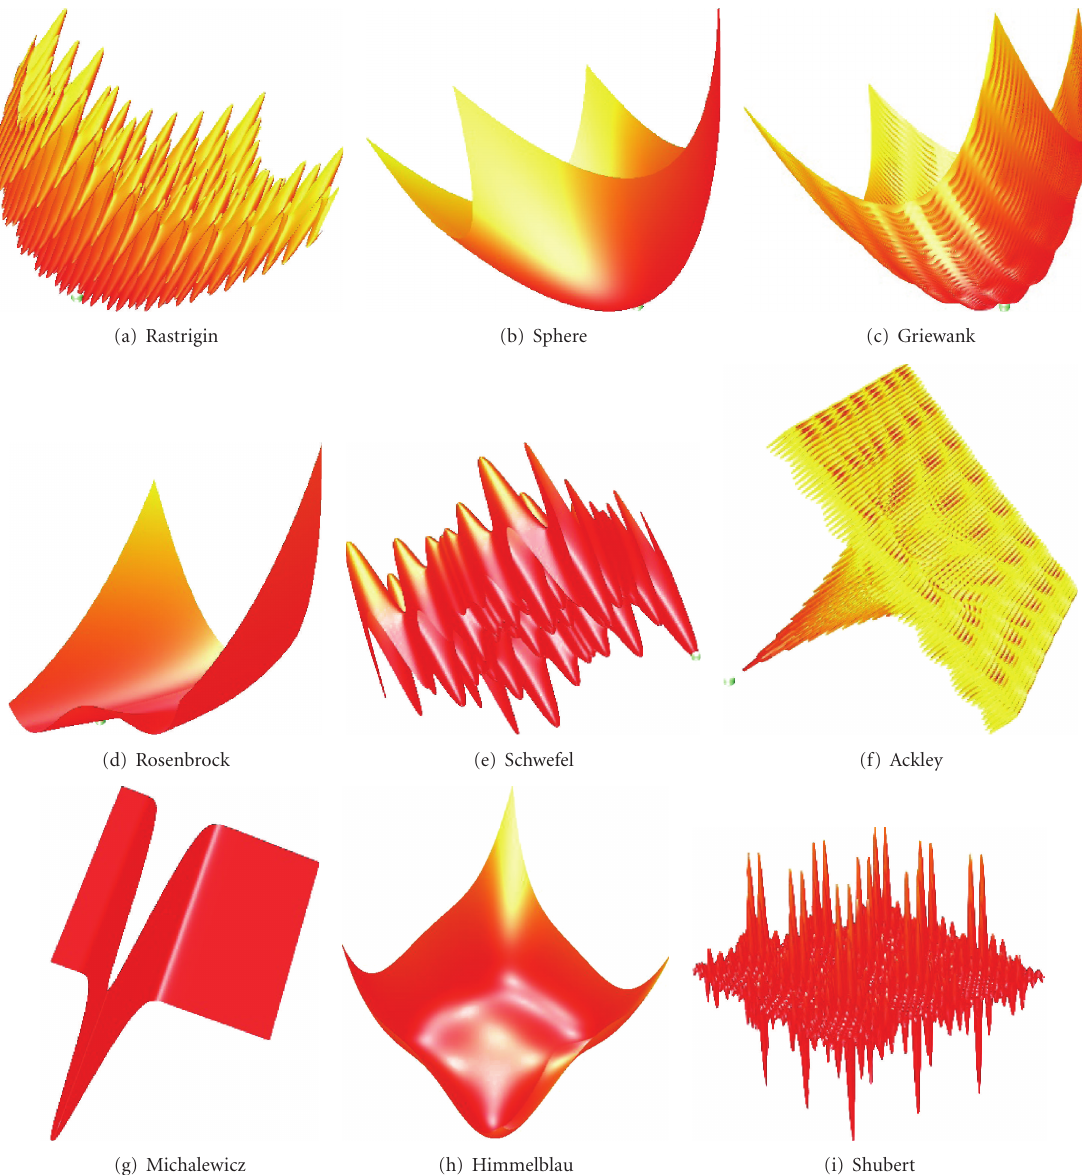
Figure 2: 3D mathematical benchmark